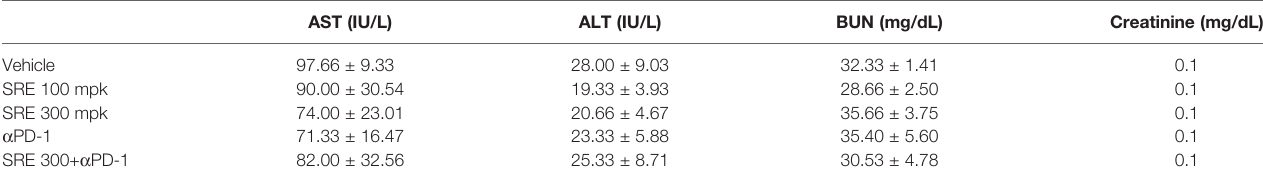
TABLE 1 | AST, ALT, BUN, and creatinine levels in SRE-treated mice serum.